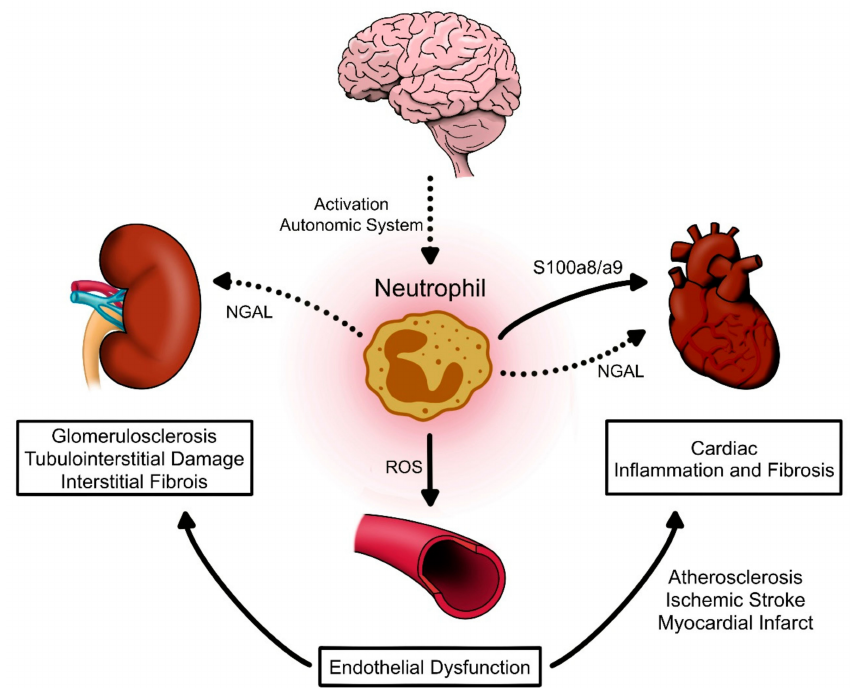
Figure 2. Neutrophil participation in cardiovascular and renal damage related to the hypertensive phenotype. During arterial hypertension (AH), where the autonomic system can activate neutrophils, neutrophils may induce vasculature damage, thereby secreting reactive oxidative species (ROS) promoting endothelial dysfunction. Once in target organs, neutrophils can contribute to inflammation, as well as cardiac fibrosis, atherosclerosis, ischemic stroke, and myocardial infarction, driving heart failure in part through NGAL and S100a8 / a9. Neutrophils can also infiltrate the kidneys in AH stimulating glomerulosclerosis, tubulointerstitial damage, and interstitial fibrosis, which are features of hypertensive kidney damage that perpetuate kidney dysfunction and that may be favored by NGAL–neutrophil